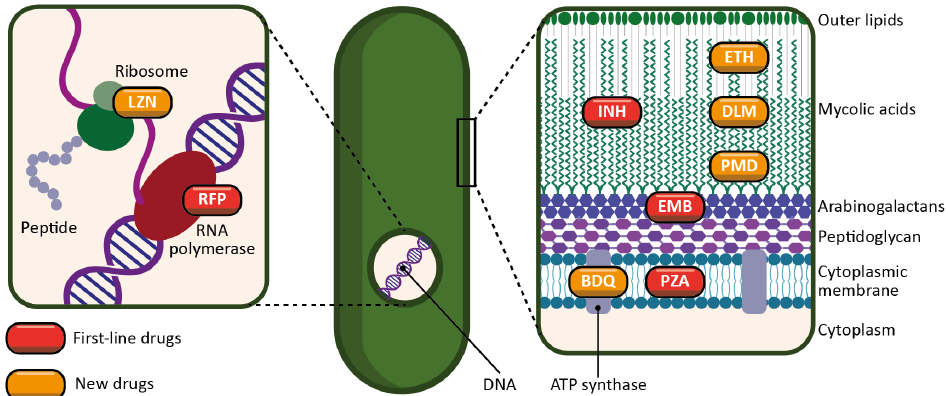
Figure 3. Schematic representation of the targets and mechanisms of action of the main antituber- cular drugs. First-line drugs are represented in red (INH: isoniazid; RFP: rifampicin; PZA: pyrazinamide; EMB: ethambutol). New drugs, either newly discovered or repurposed, are represented in orange (ETH: ethionamide; LZN: linezolid; BDQ: bedaquiline; DLM: delamanid; PMD: preto- manid).